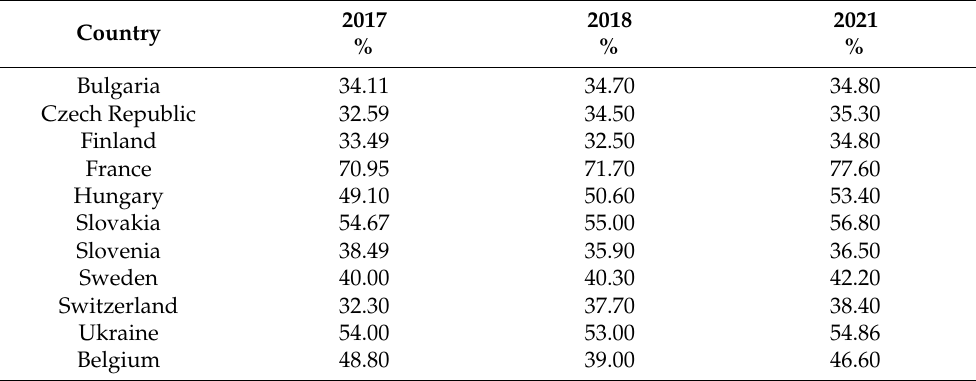
Table 4. Distribution of nuclear energy in total energy consumption in the countries using the most (above 30%) nuclear energy in 2017 and 2018 (source: World Nuclear Association), and 2021 (source: GaBi 8.0